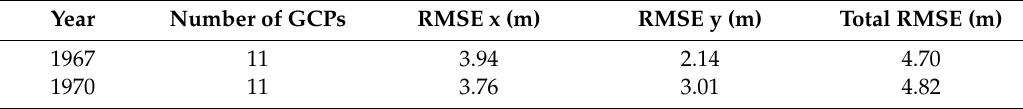
Table 5. Root mean square error (RMSE) of Corona data ortho-rectification in 1967 and 1970.